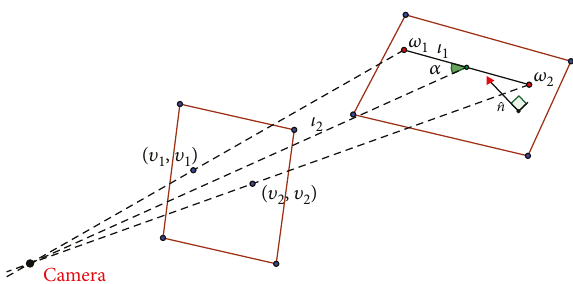
Figure 3: An illustration of the information needed to fi nd Δ α , where α is the green